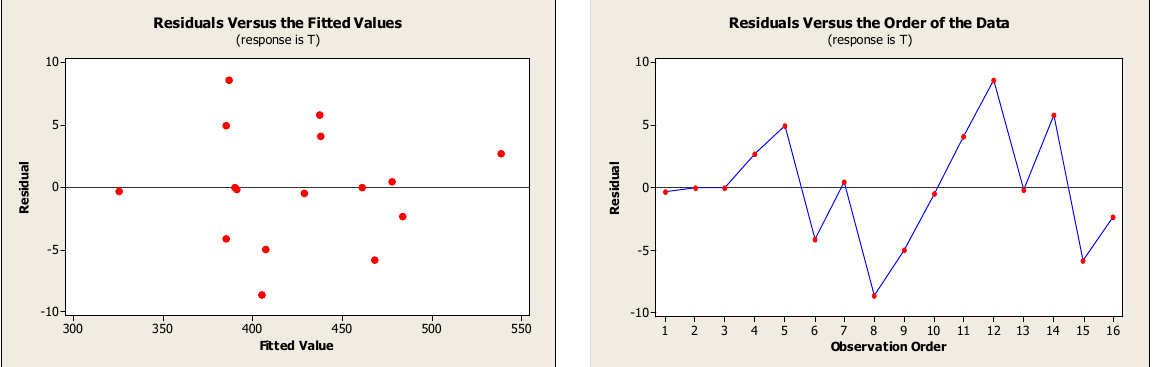
Fig. 4. Residuals vs. fitted values Fig. 5. Residuals vs. order of the